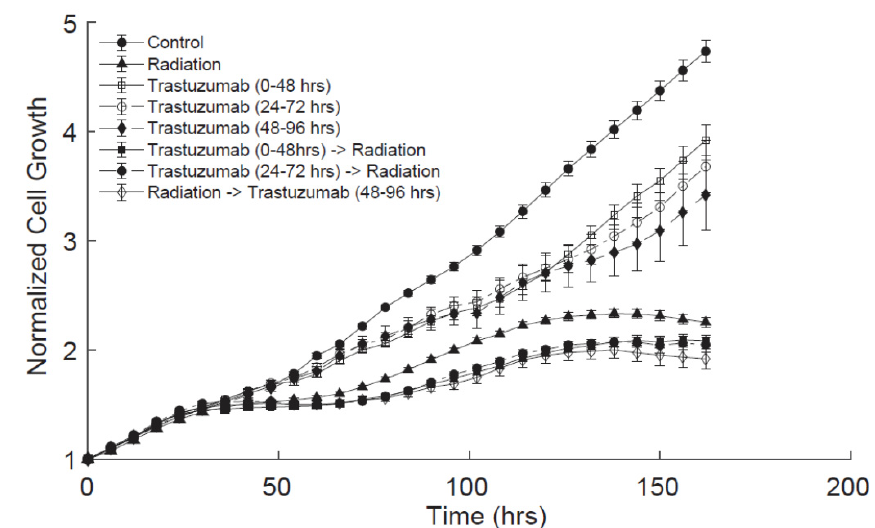
Figure 3. Differences in BT474 cell growth with trastuzumab administered before, at the same time, or after radiation therapy. Treatment with trastuzumab before radiation did not significantly alter cell response to therapy compared with trastuzumab treatment at the same time ( p = 1.00) or treatment after radiation ( p = 0.98). Treatment with trastuzumab at the same time did not significantly alter the cell response to therapy compared with treatment after radiation ( p = 0.93). Altering the order of dosing trastuzumab and radiation did not alter the cell response to treatment in vitro.